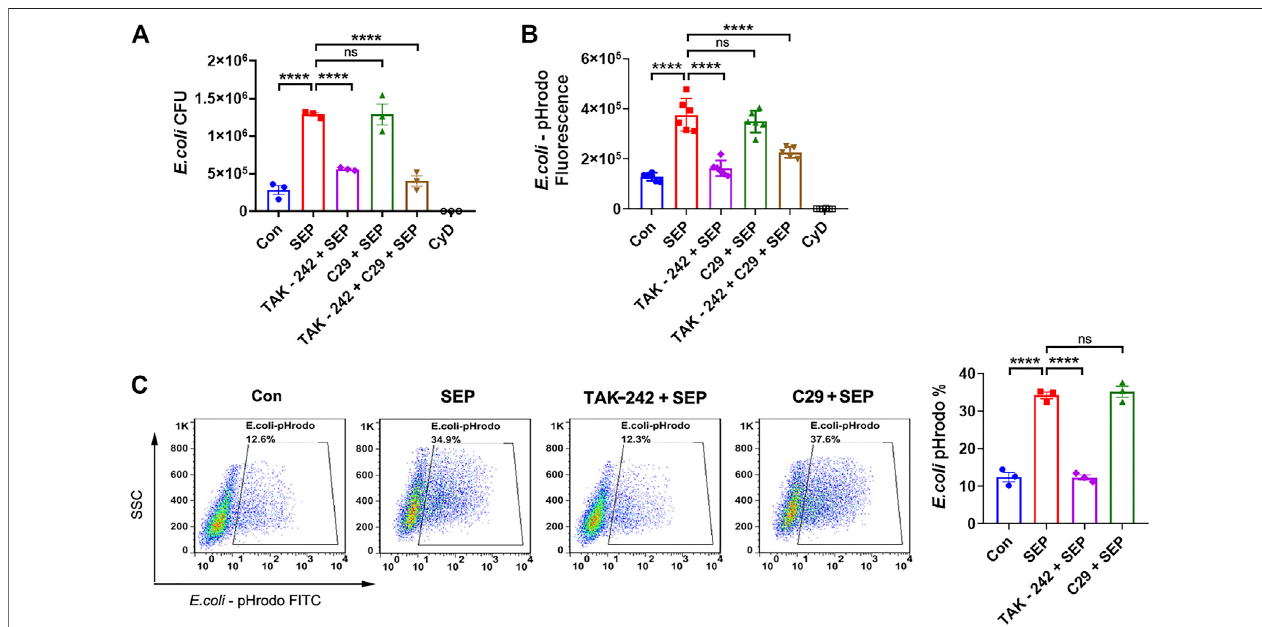
FIGURE 2 | SEP promotes macrophages phagocytosis via TLR4. RAW264.7 cells were pre-treated with TLR2 inhibitor C29 (50 μ M) or TLR4 inhibitor TAK-242 (20 μ M) for 2 h, then stimulated with SEP (100 μ g/ml) for another 24 h. (A) Phagocytosis of live E. coli by macrophages were measured by gentamicin protection assay. (B) Phagocytosis of pHrodo- E. coli by macrophages were quanti fi ed by fl uorescence intensity. (C) The positive cell rates for phagocytosis of pHrodo- E. coli by macrophage were detected by fl ow cytometry. All data are represented as mean ± SEM acquired in triplicate determinations. **** p < 0.0001. ns, not signi fi